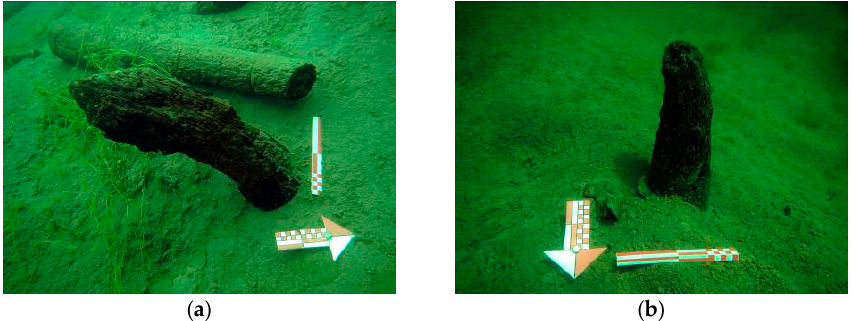
Figure 14. Silty clay bumps during underwater surveys in Lago Tramonto, Gambulaga, Portomaggiore (FE, Italy): ( a ) Standing pole and tapered pole with engraved lines; ( b ) Standing pole (photo by Giovanna Bucci).